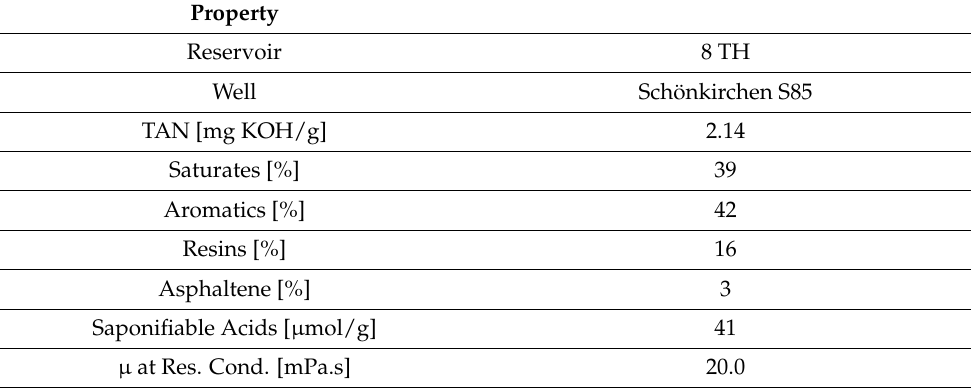
Table 1. Composition of crude oil used in this work.